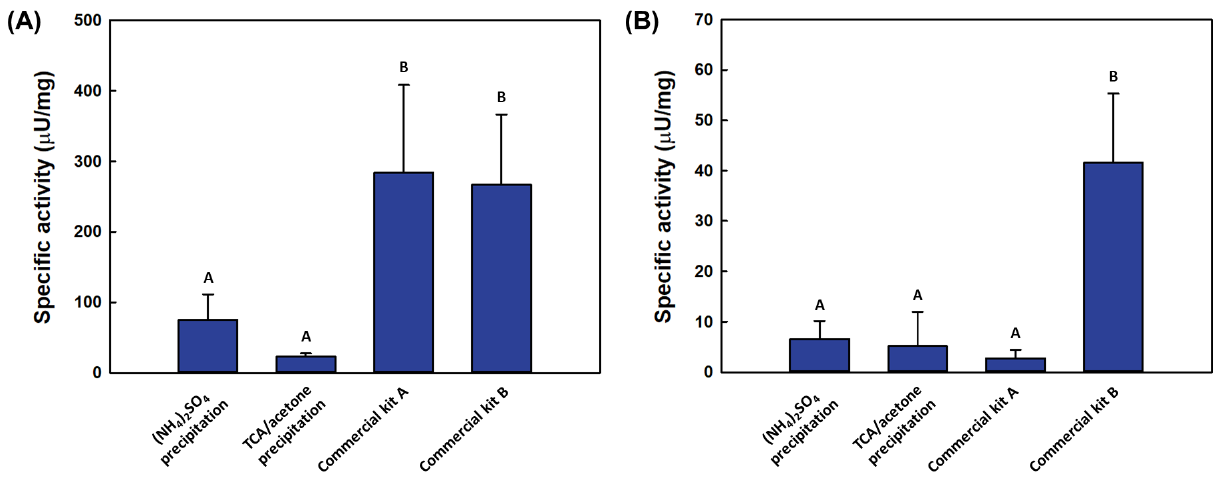
Figure 3. Detected specific activity of the extracts from 24 Korean domestic agricultural products according to the protein extraction methodologies. ( A ) Spectrophotometric assay. ( B ) Fluorometric assay. Means with different superscripts differ significantly ( p < 0.05).